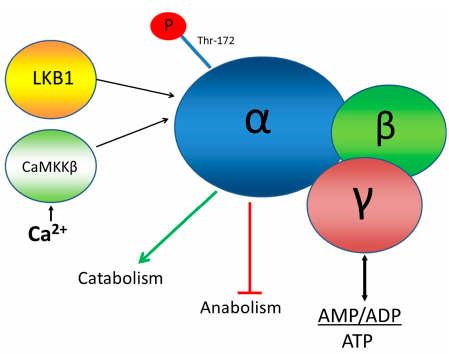
Figure 1. Schematic representation of the structure of AMPK, its regulation and function. Energetic status is sensed by the gamma subunit. The catalytic alpha subunit functions as the effector of this protein complex by phosphorylating target proteins for metabolic regulation.